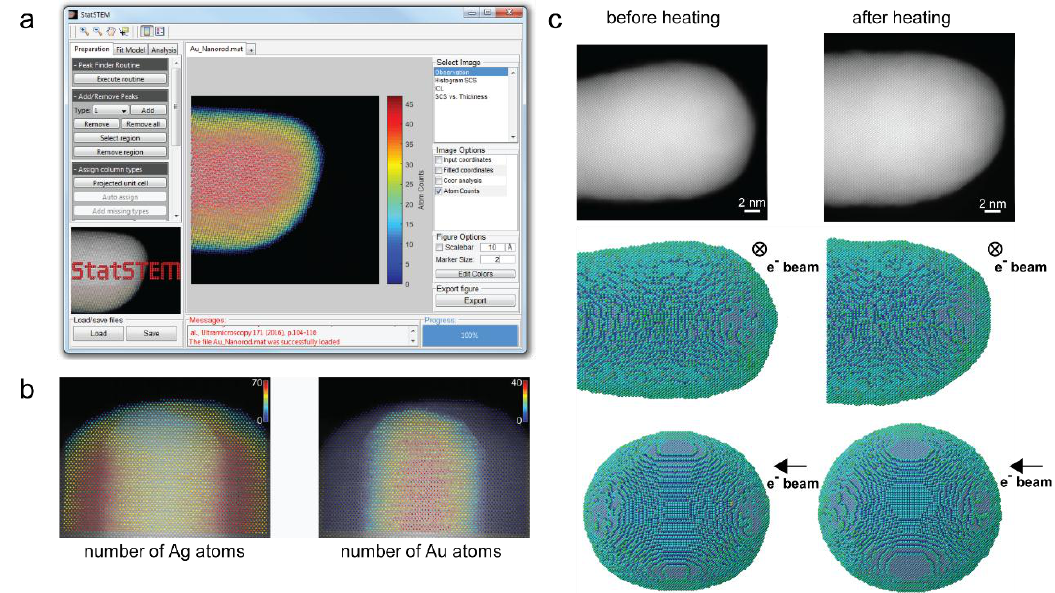
Figure 2. ( a ) Screen shot of the StatSTEM software, showing the atom-counting results on an experimental image of a Au nanorod; ( b ) Counting the number of atoms from a HAADF-STEM image of a Ag-coated Au nanorod; and ( c ) 3D atomic scale characterization of a Au nanodumbbell before and after